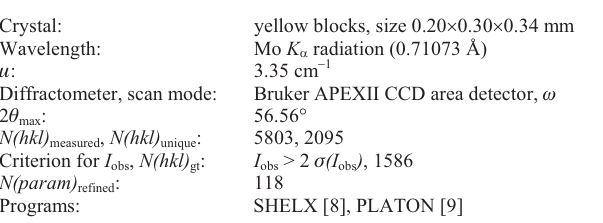
Table 1. Data collection and handling.